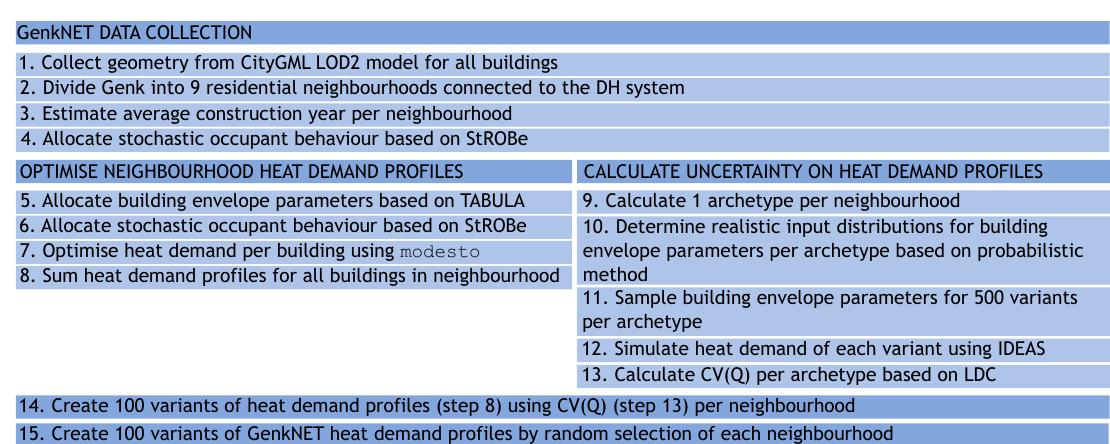
Figure 1. A flow chart describing the different steps taken to determine the GenkNET heat demand profiles including uncertainties (relevant to both Sections 2 and 3).